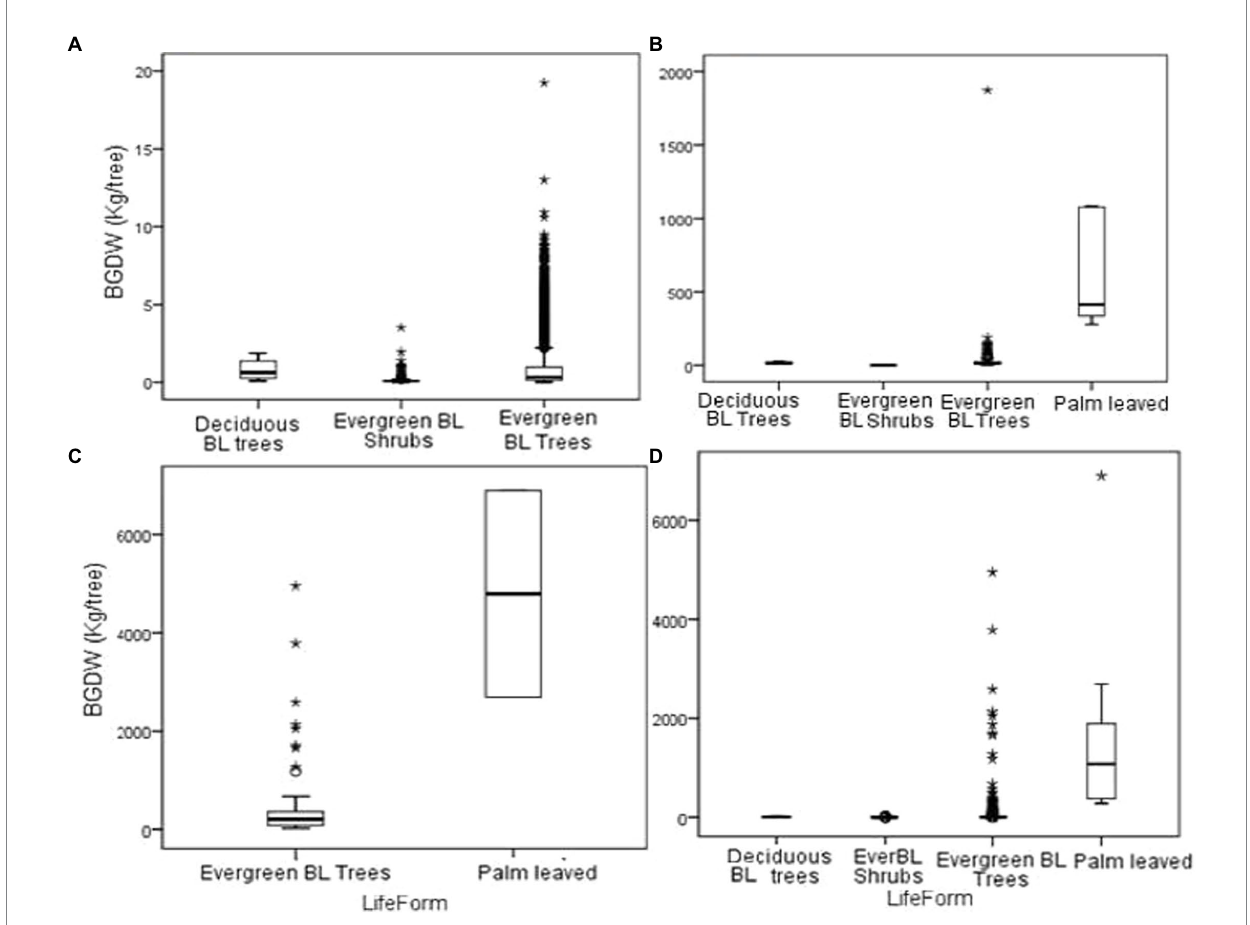
FIGURE 5 Below ground dry weight (ABDW) for Dinghushan forest: (A) below 10 cm DBH; (B) 10– 30 cm DBH; (C) above 30 cm DBH and (D) the entire forest data. *BL (Broad leaved).